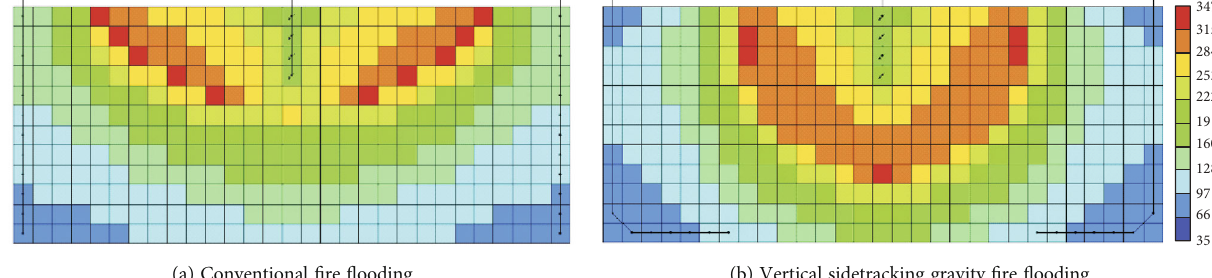
Figure 4: Comparison of temperature fi eld between conventional fi re fl ooding and vertical sidetracking gravity fi re fl ooding.